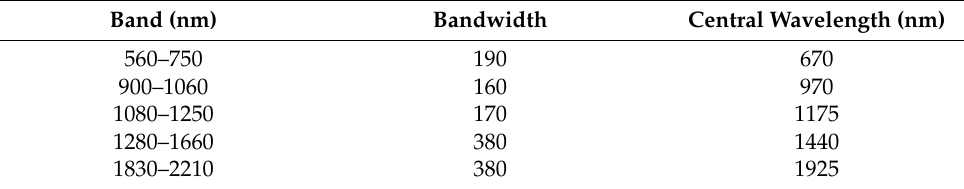
Table 2. Spectral intervals for continuum removal variables.